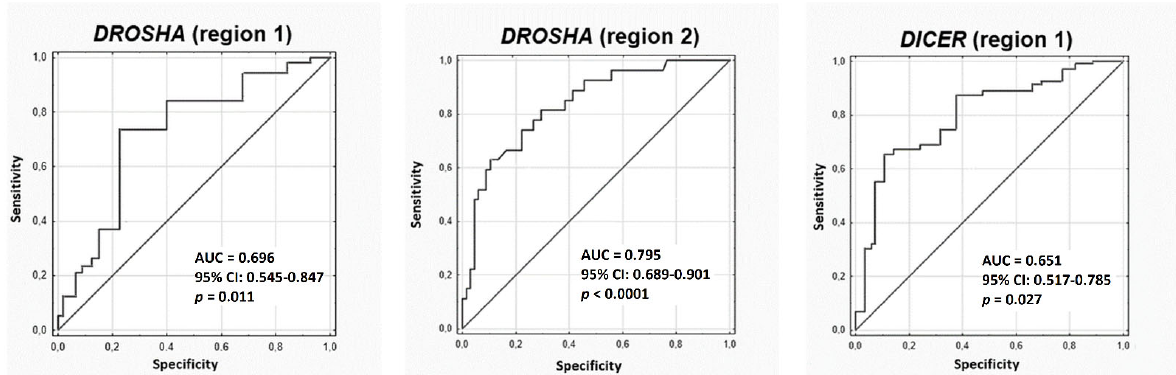
Figure 3. ROC curves analysis to distinguish between healthy individuals and patients with early stages of lung cancer on the basis of the relative methylation level of the DROSHA and DICER genes (description in the text). Based on data available in The Cancer Genome Atlas (TCGA), we performed validation of the obtained experimental results. In silico analysis revealed a significantly higher relative methylation of DICER in samples from patients with lung adenocarcinoma (LUAD project) compared to the control (solid normal tissue) ( p = 0.0003; Figure S1A). In turn, such an analysis shows an insignificantly higher relative methylation of DROSHA in samples from patients with lung adenocarcinoma compared to the control ( p = 0.1020; Figure S1B). Moreover, ROC analysis of TCGA data revealed that the relative methylation of DICER was characterized by 37.3% sensitivity and 77% specificity in differentiating lung cancer from the control (AUC = 0.539, 95%CI: 0.530–0.548, p = 0.0001; Figure S2A). On the other hand, the relative methylation of DROSHA was characterized by 27.1% sensitivity and 82.4% specificity in the differentiation of lung cancer and the control (AUC = 0.532, 95%CI: 0.502–0.561; p = 0.1037; Figure S2B). We evaluated the expression of DROSHA and DICER in 45 NSCLC patients (44.5% of the study group). In that group were 33 males (73.3%) and 12 females (26.7%). Eight patients (17.8%) were in stages IA–IIIA and 37 (82.2%) in stages IIIB–IV. Thirty ‐ two patients (71.1%) had lymph node metastases, whereas distant metastases were observed in 34 patients (75.5%). AC and SqSC were diagnosed in 21 (46.7%) and 20 (44.4%) patients, respectively. The tumour was classified as NOS in 4 patients (8.9%). We found no statistically significant correlation (or even a trend) between the level of methylation and the expression of DROSHA and DICER genes ( p > 0.1). Similarly, we found no correlation between the DROSHA and DICER gene expression and demographic and clinical variables. The only exceptions were a significantly higher level of DICER expression in patients with early stages (IA–IIIA) compared to those in advanced stages (IIIB–IV) ( p = 0.002, Figure 4A), and in patients without lymph node metastases ( p = 0.045, Figure 4B) compared to those with metastatic lymph nodes.